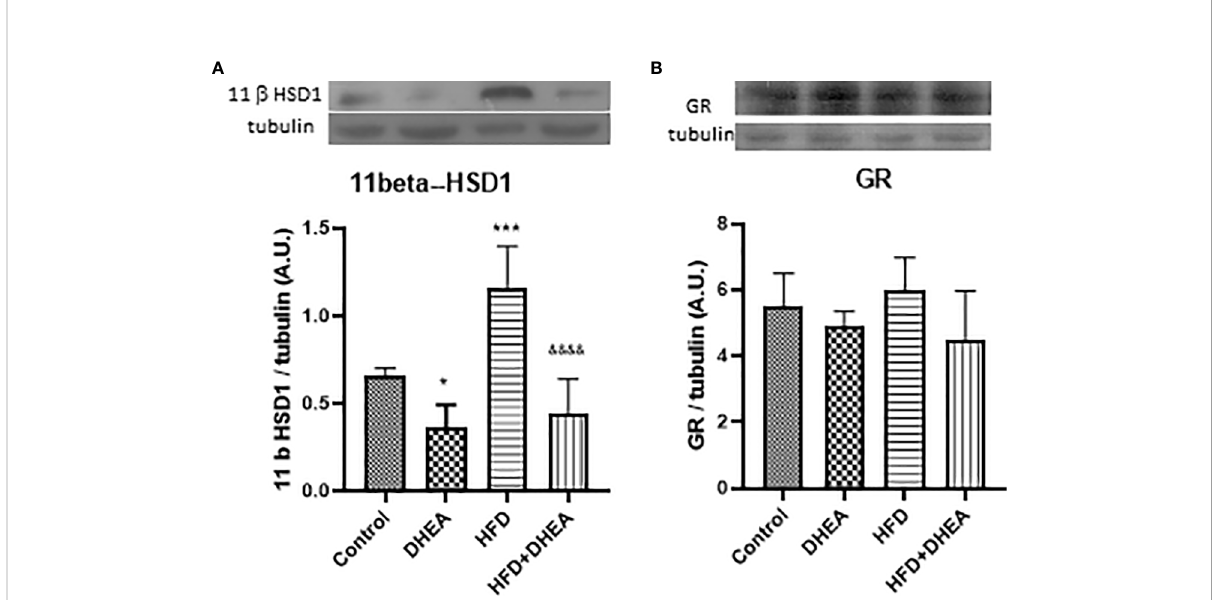
FIGURE 4 Expression of 11 b -HSD 1 and GR. Expressions of 11 b -HSD 1 (A) and GR (B) were measured by Western blot in lung homogenates. Representative immunoblots of three experiments in duplicate and graphical representations of protein expressions normalized to the amount of b -tubulin are shown. *p < 0.05 *** p < 0.001 versus C and &&&& p < 0.0001 versus